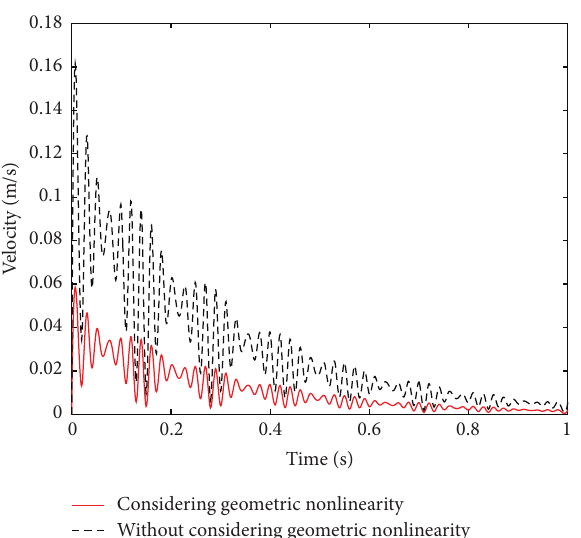
Figure 7: Equivalent stress of driving limb